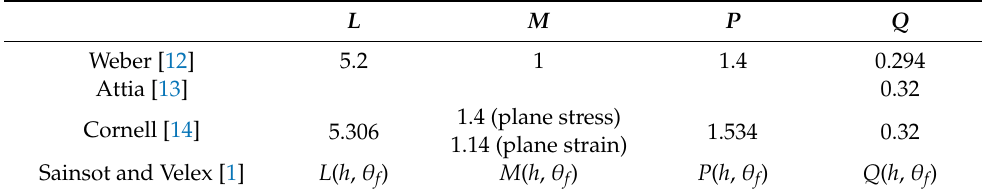
Table 1. L , M , P and Q values used in four different papers.